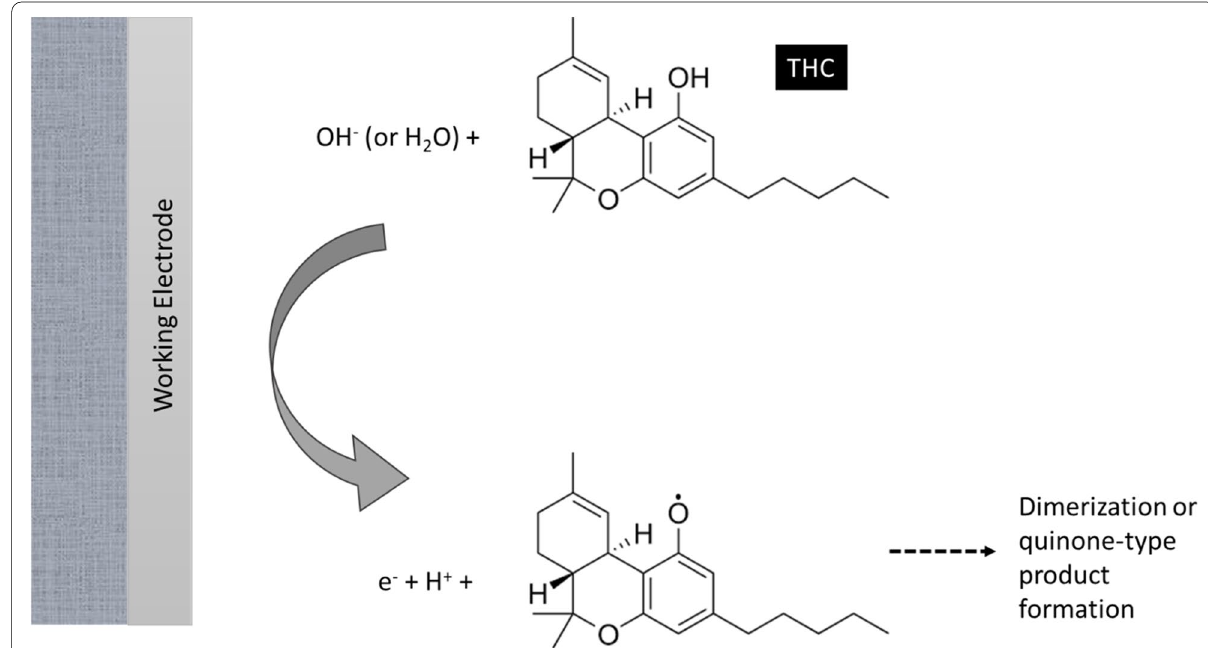
Fig. 1 Mechanism of detection of THC on an electrochemical sensor. The illustrated mechanism is according to (Renaud-Young et al.